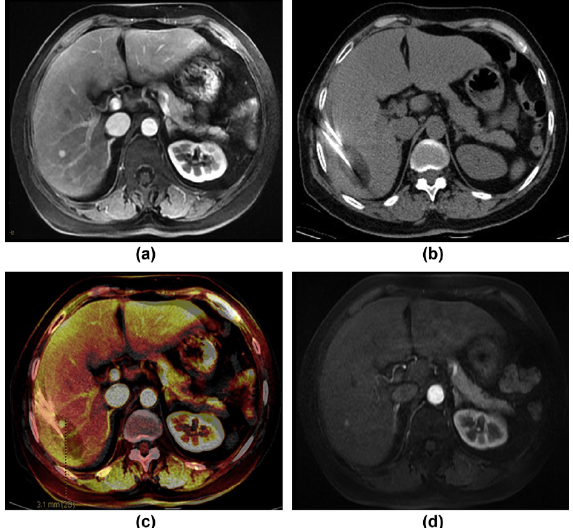
Figure 4. A 59-year-old man with hepatocellular carcinoma (HCC) following radical resection, who was treated with percutaneous cryoablation. ( a ) A single tumor measuring 0.8 cm is noted in segment 5 on the portal phase of contrast-enhanced magnetic resonance image (MRI) before cryoablation. ( b ) The intraoperative CT image at the end of cryoablation shows a clear ablation zone. ( c ) The fusion image is created after automatic rigid registration combined with manual correction. The medication-assisted manipulation (MAM) is categorized as group II: MAM 0e5 mm. ( d ) Contrast-enhanced MRI image obtained 4 months after cryoablation shows Local Tumor Progression (LTP) [180].